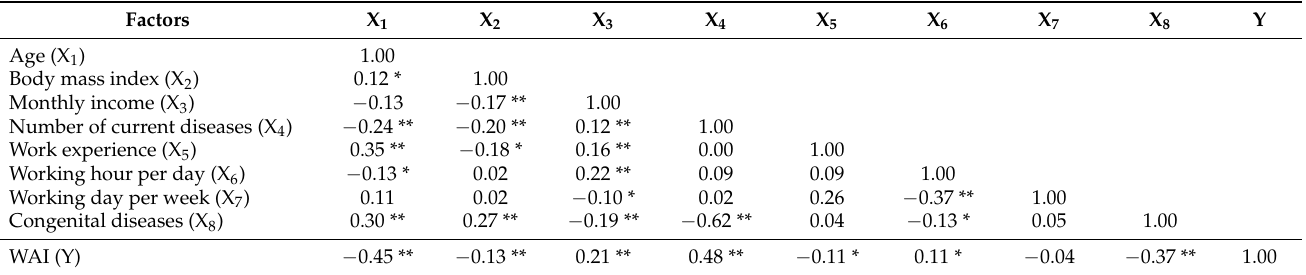
Table 4. Pearson’s correlation analysis for different individual and work-related factors.